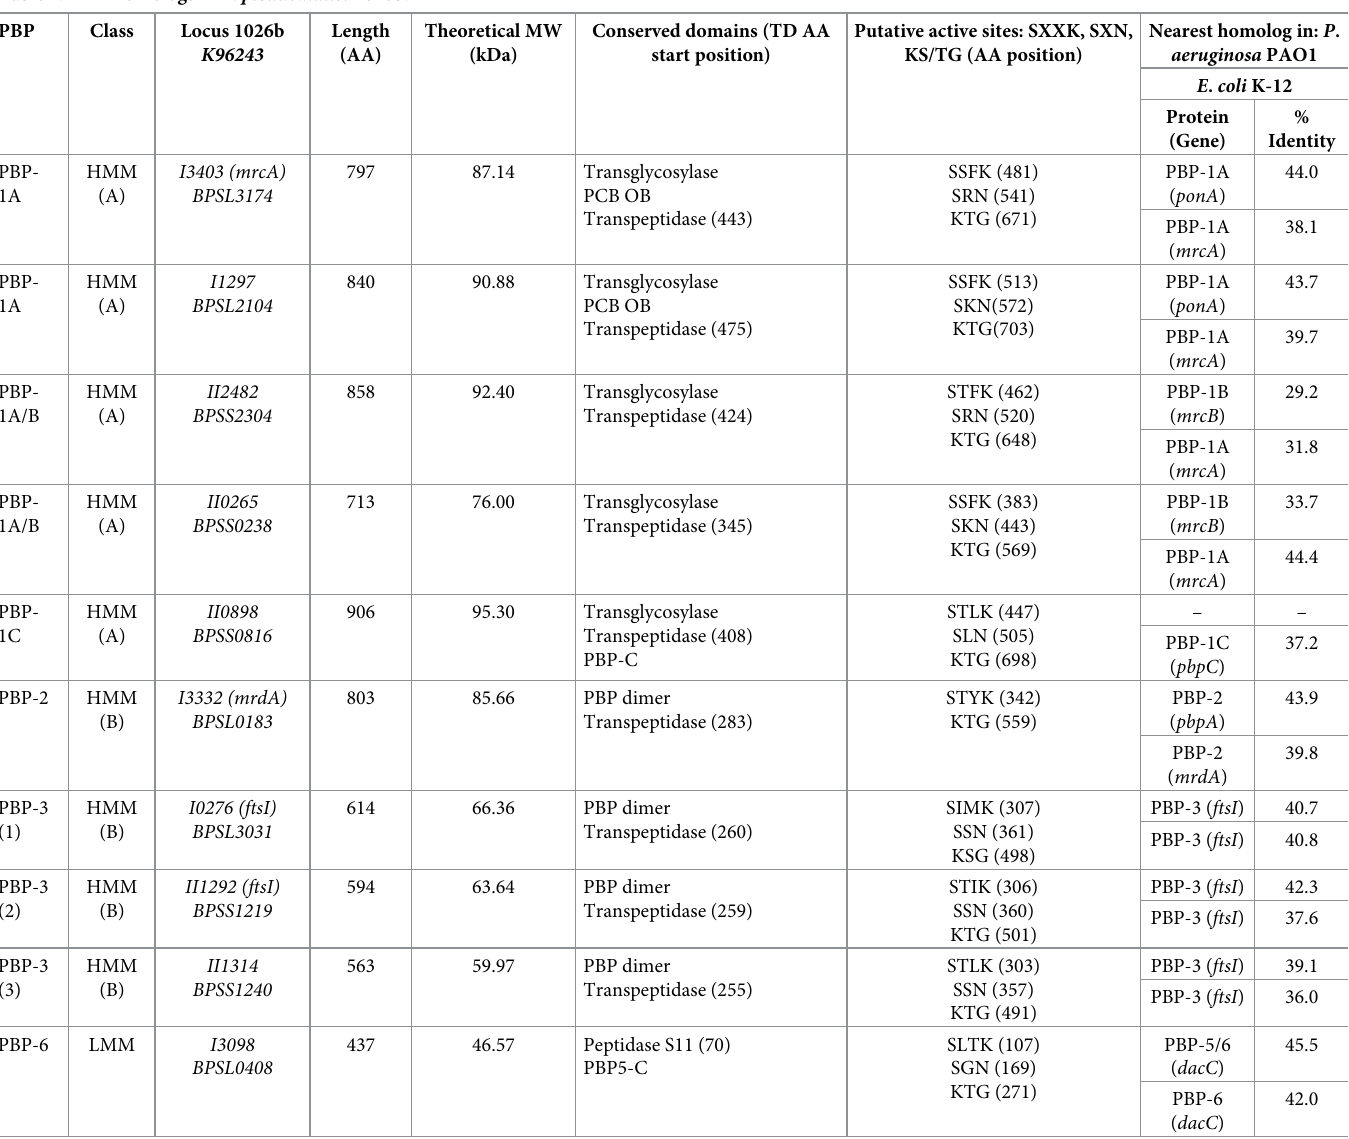
Table 1. PBP homologs in B . pseudomallei